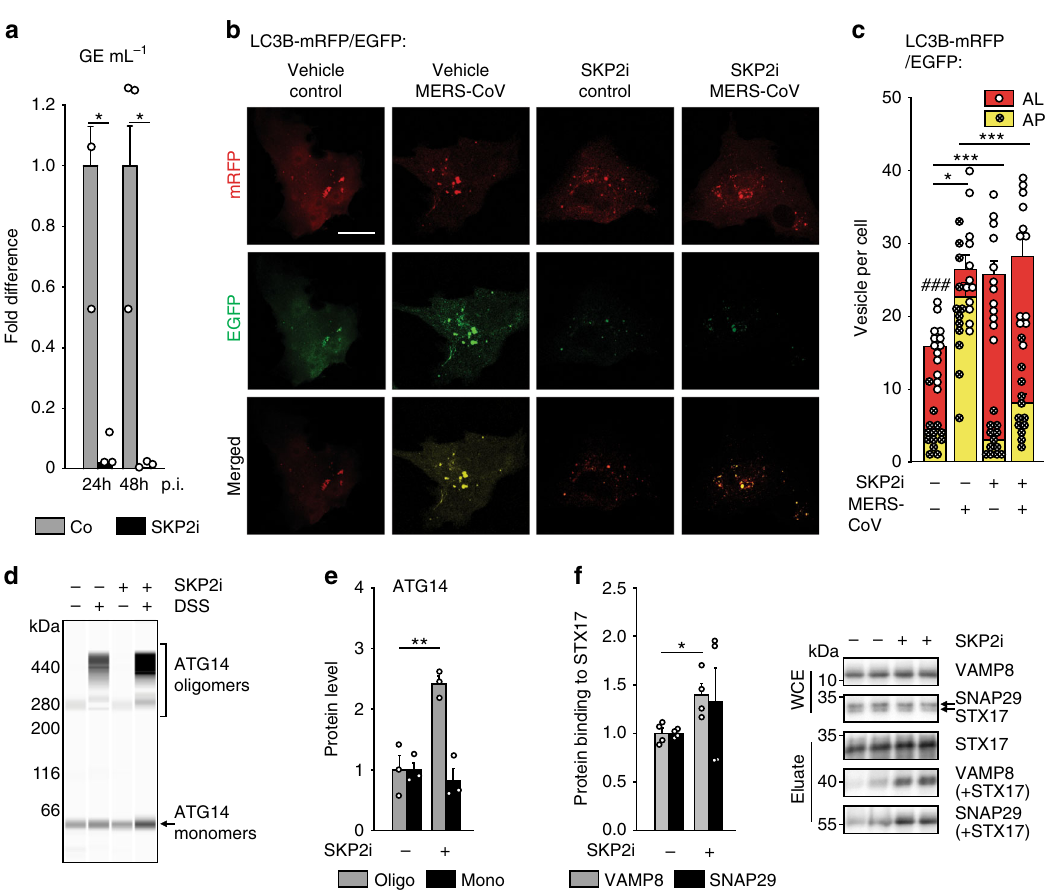
Fig. 8 SKP2 inhibition reduces replication of MERS-CoV and its effects on autophagy. a The SKP2 inhibitor (SKP2i) ef fi ciently inhibits MERS-CoV replication. VeroB4 cells were infected with MERS-CoV (MOI = 0.001) and treated with SKP2i (10 µ M) or DMSO (Co = control). MERS-CoV GE were determined by real-time RT-PCR at 24 and 48 h p.i., data are presented as fold difference (black bars, SKP2i condition) in comparison to control (gray bars, Co = DMSO condition). Raw data presenting GE ml^-1 is shown in Fig. S5A. b , c The SKP2-inhibitor (SKP2i) restores autophagic fl ux in MERS-CoV-infected